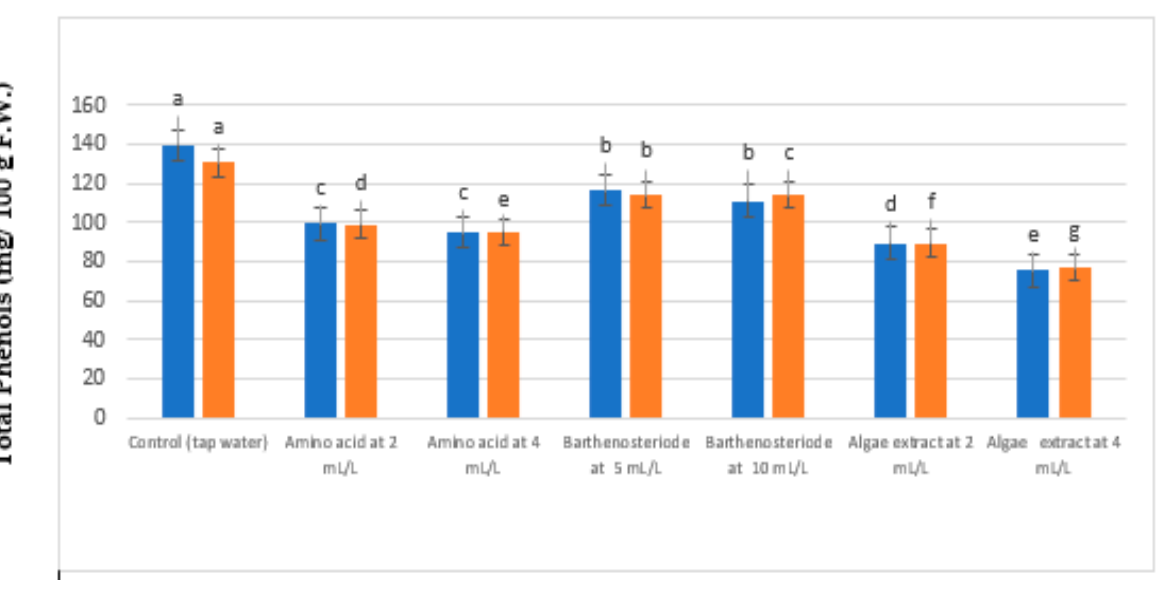
Figure 5. Effect of various bio-stimulant treatments on chia (Salvia hispanica L.) plant total phenols (mg/100 g F.W.) during the 2019–2020 and 2020–2021 seasons. For the same column, means followed by the same letter are not statistically different, according to the Tukey multiple range test.